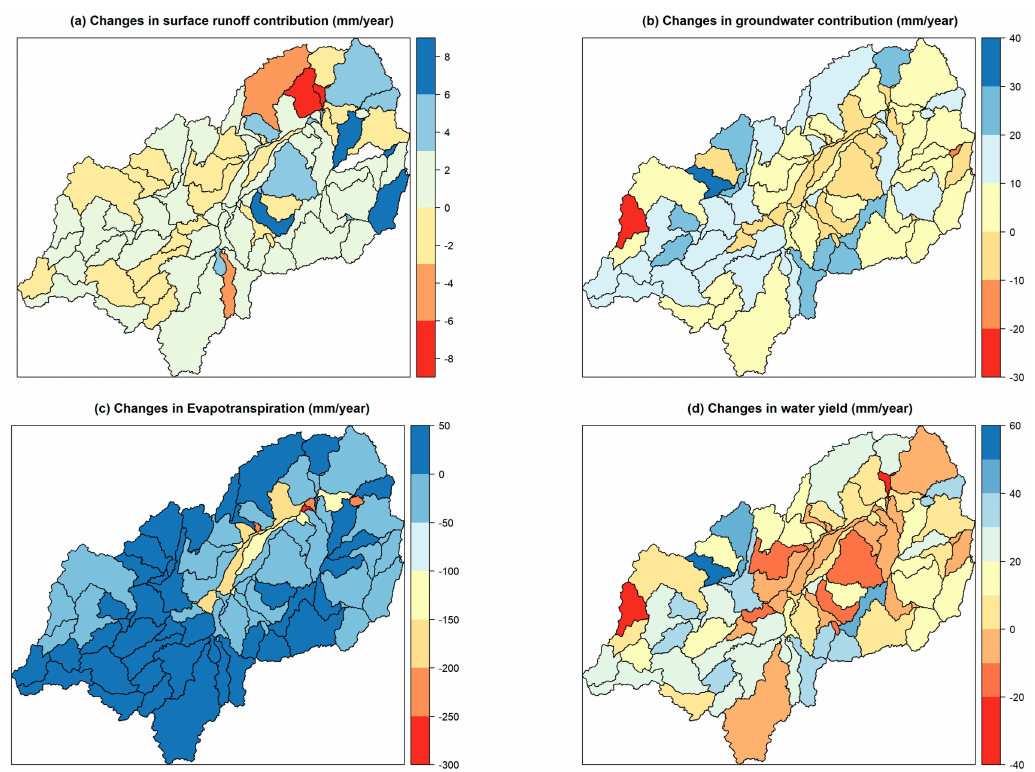
Figure 12. Average shifts in water balance components (in mm) for the simulation period, comparing changes from the 1970s land use map with the 2014 land use map. ( a ) Deviations in surface runoff, ( b ) groundwater contribution, ( c ) evapotranspiration, and ( d ) the overall water yield are